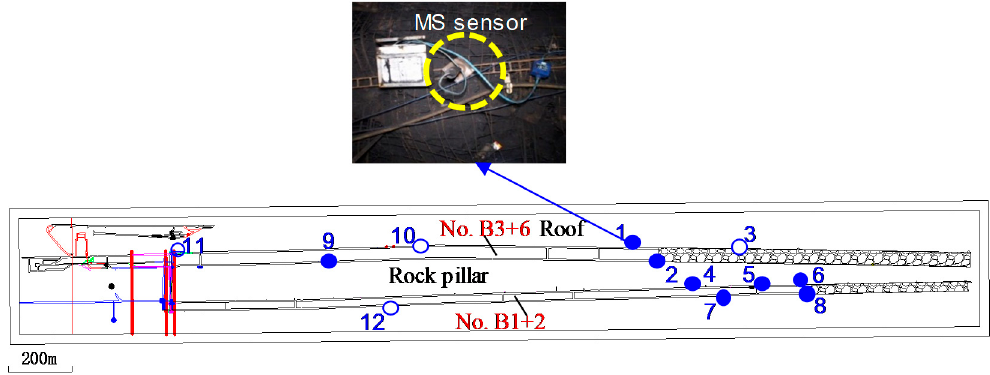
Figure 6. Probes installation position of the MS monitoring system when the “4 26” rockburst occurred.